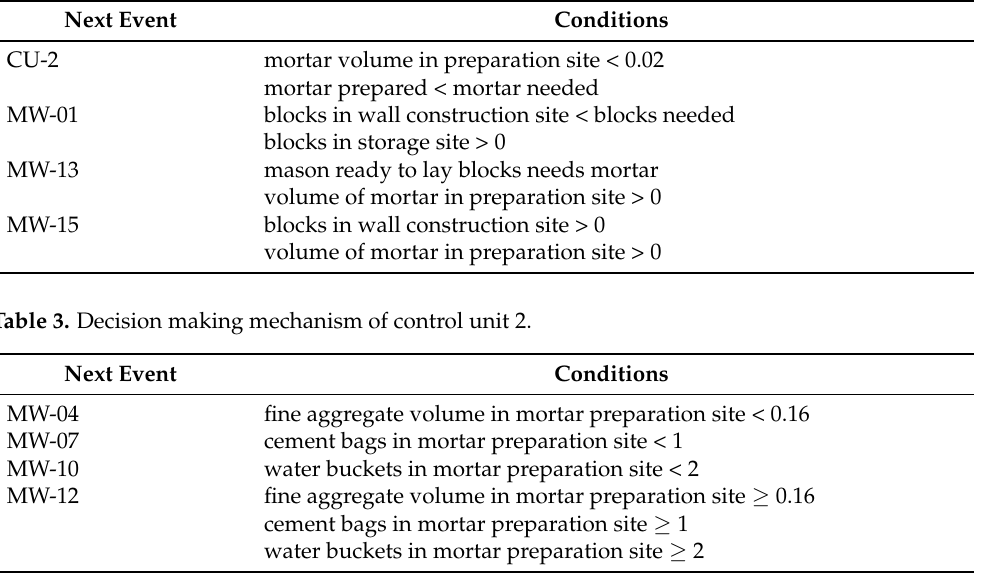
Figure 11. Generic simulation model of the selected construction activity. Table 2. Decision making mechanism of control unit 1.